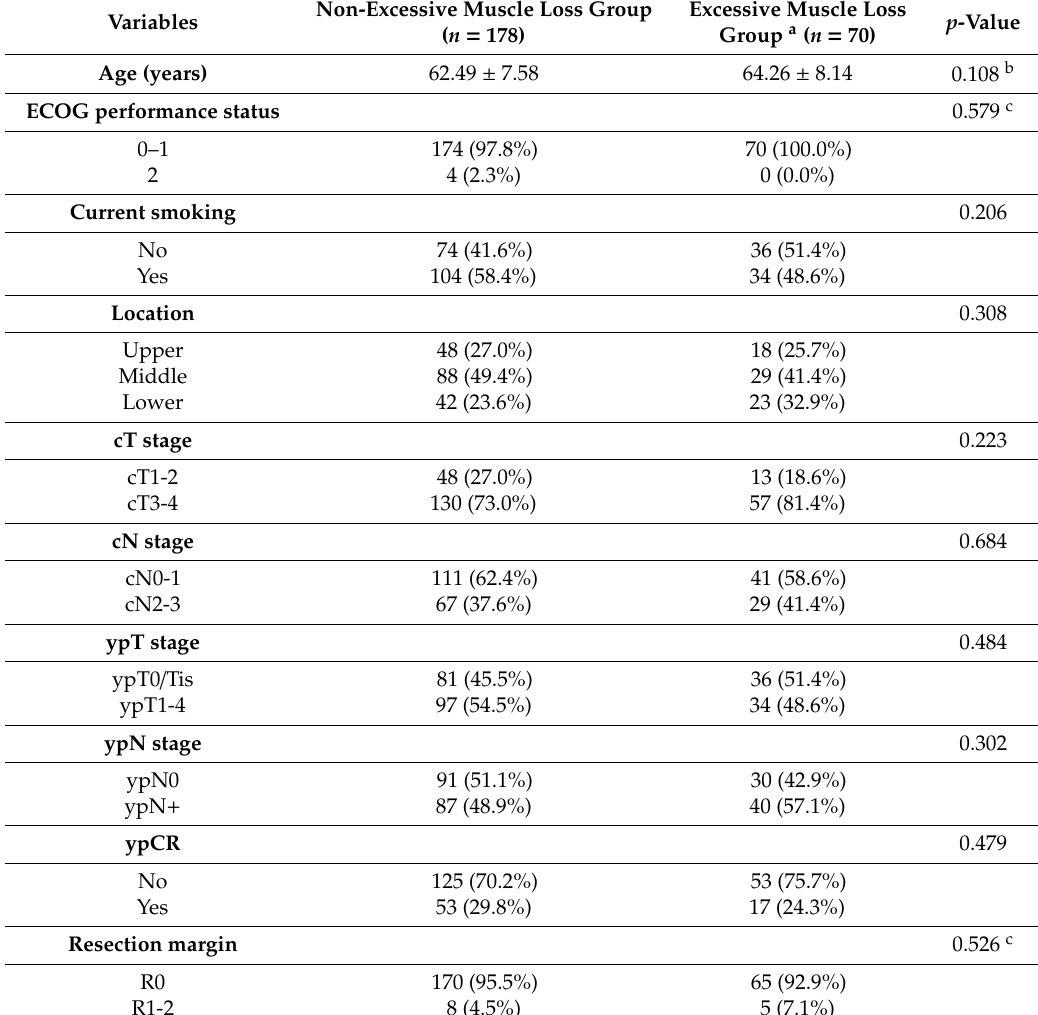
Table 3. Comparison of clinicopathologic characteristics between excessive muscle loss group and non-excessive muscle loss